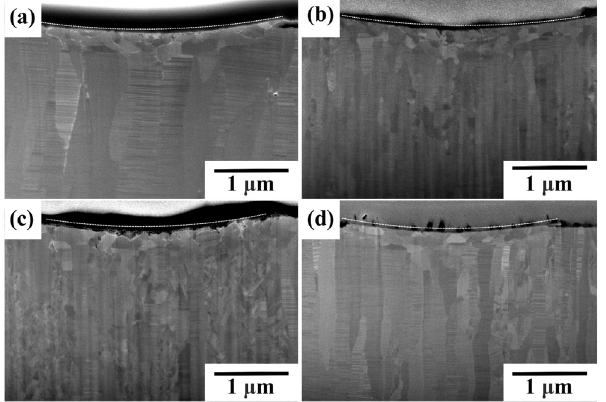
Fig. 4 FIB cross-sectional images (imaged at 52° tilt angle) perpendicular to the sliding direction of NT Cu alloys showing deformation-induced microstructure changes in the vicinity of the scratch surface after 50 sliding passes. (a) Cu-2wt.%Al alloy; (b) Cu-4wt.%Al alloy; (c) Cu-6wt.%Al alloy; (d) Cu-10wt.%Ni alloy. The position of the spherical indenter is indicated by the dashed line. In all cases, a clear boundary between the original micro- structure and the deformed region can be